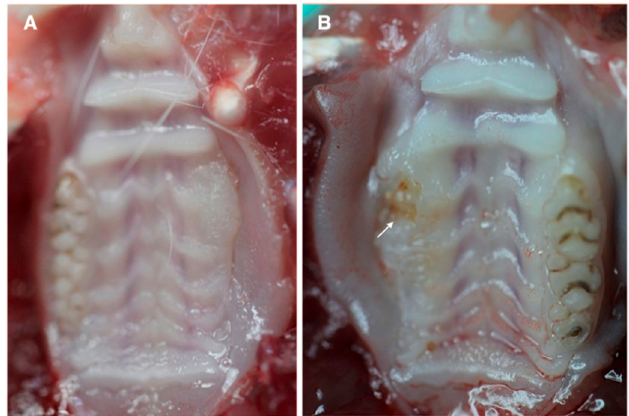
Figure 3. Tooth extraction sites in ZA-treated rat mandibles 4 weeks after being transplanted with ( A ) BM-MSC + β -TCP scaffold or ( B ) control saline + β -TCP scaffold. The last group displayed osteonecrotic lesions such as mucosal ulcerations and exposure of necrotic bone areas.